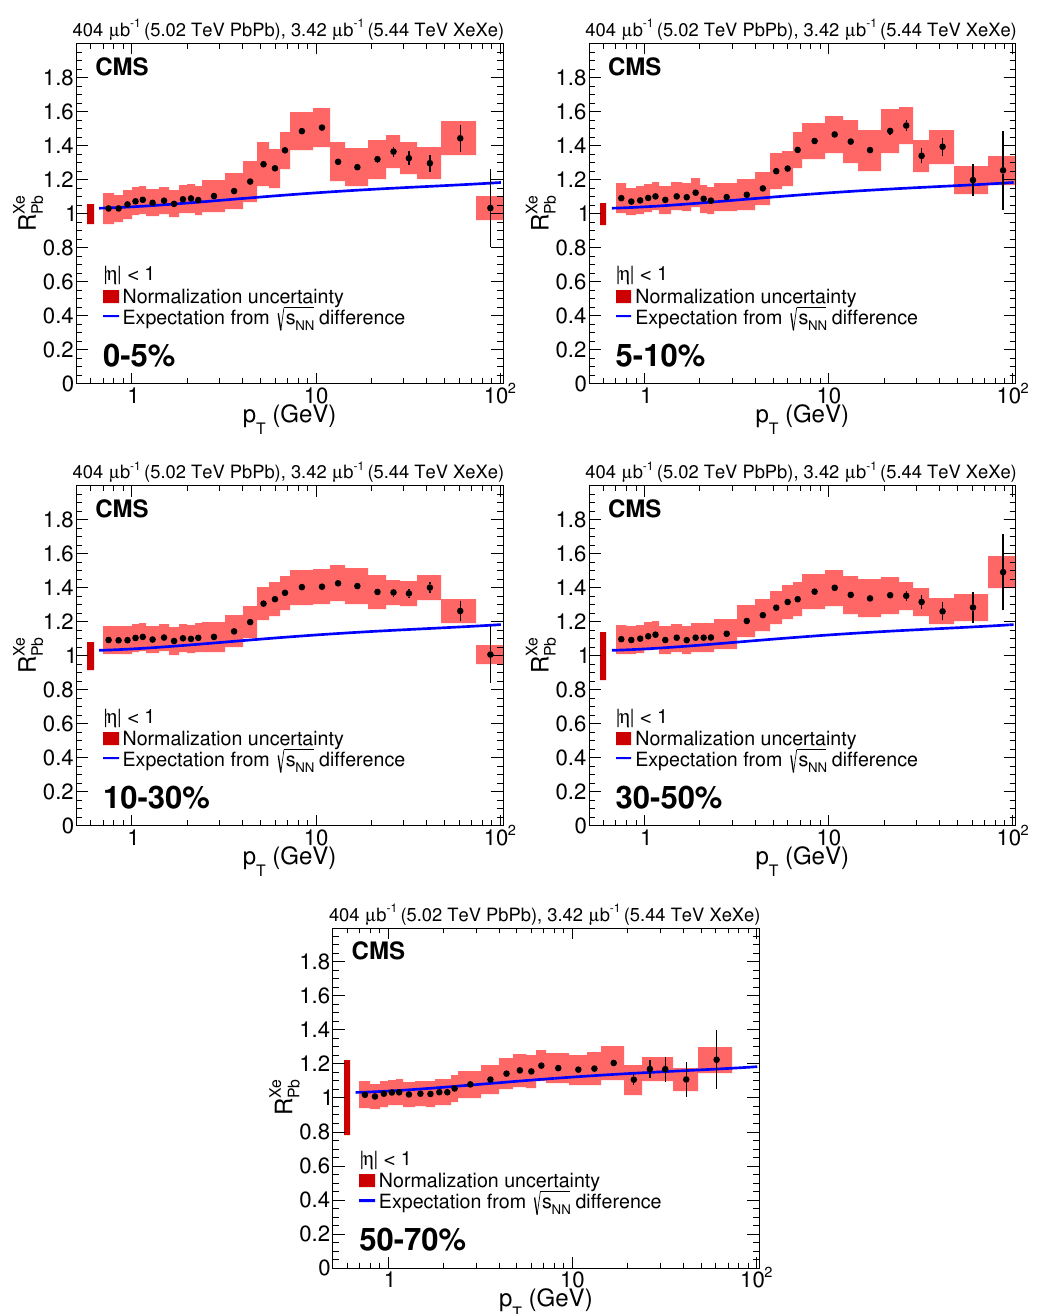
Figure 5 . The measurement of R Xe in (cid:12)ve centrality classes using the results of this analysis Pb and data from ref. [17]. The blue line represents the expected deviation from unity caused by the di(cid:11)erent center-of-mass energies of the two collision systems. The solid pink boxes represent the systematic